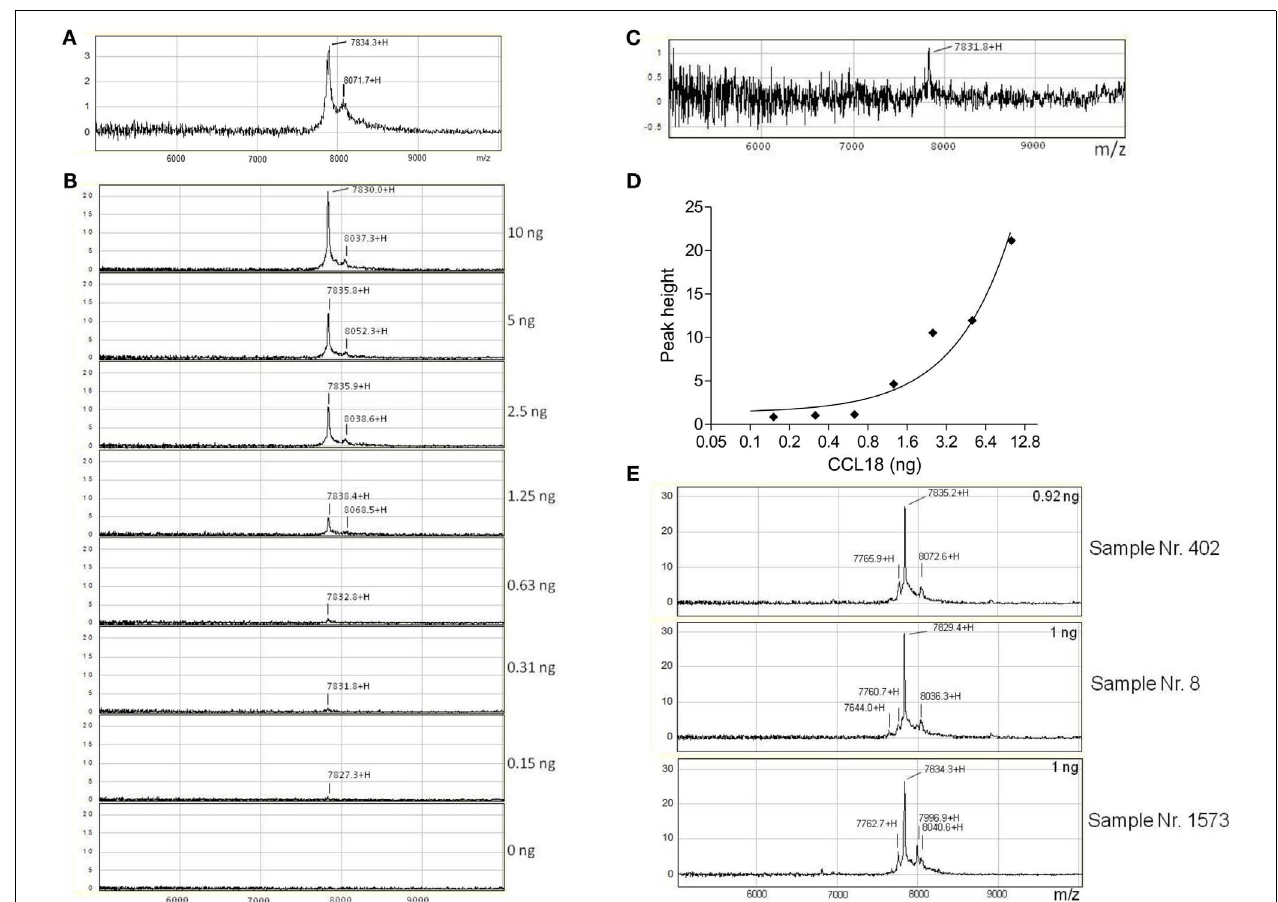
Arrays containing immobilized polyclonal anti-CCL18 antibodies. (C) Increase in scale at 0.31ng. (D) Peak height displayed according to amount of recombinant CCL18. (E) RS100 ProteinChips were coated with polyclonal anti-human CCL18 antibodies and incubated with synovial fluid from RA (Sample number 402 and 8) or OA (Sample number 1573) patients. Mass spectra were generated by SELDI-TOF MS. Spectra are representative for four RA and OA patient samples